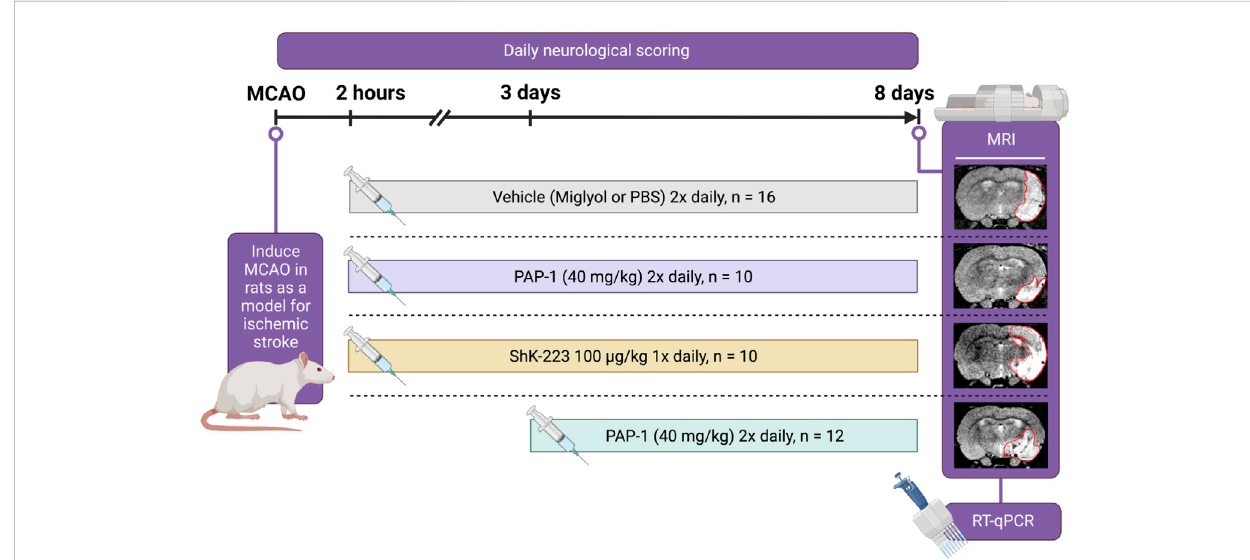
FIGURE 1 Experimental Paradigm. Cartoon showing the experimental design, the timeline, and the treatment